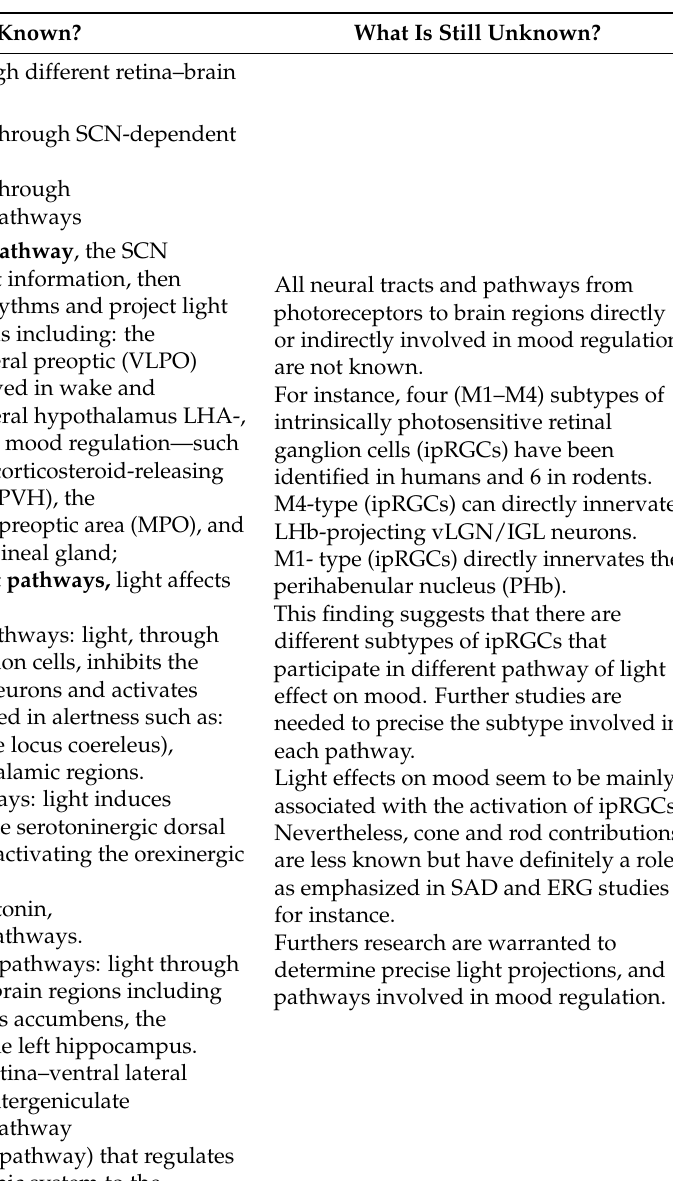
Table 1. What is known and what is still